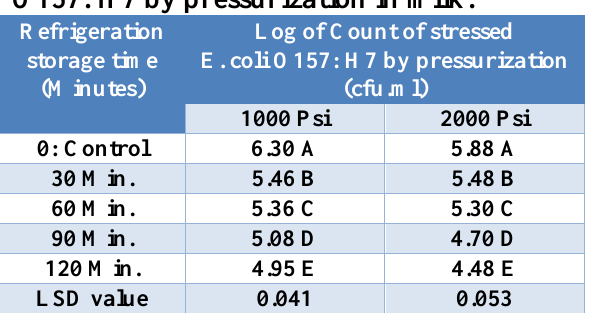
Table, 4: Effectiveness of crude bacteriocin on the viability loss of stressed E. coli O157: H7 by pressurization in milk.